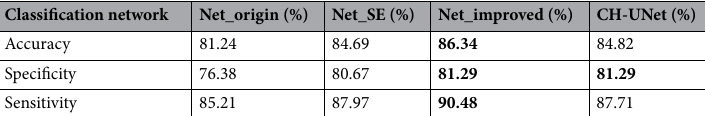
Table 6. Classification network test comparison. Significant values are in